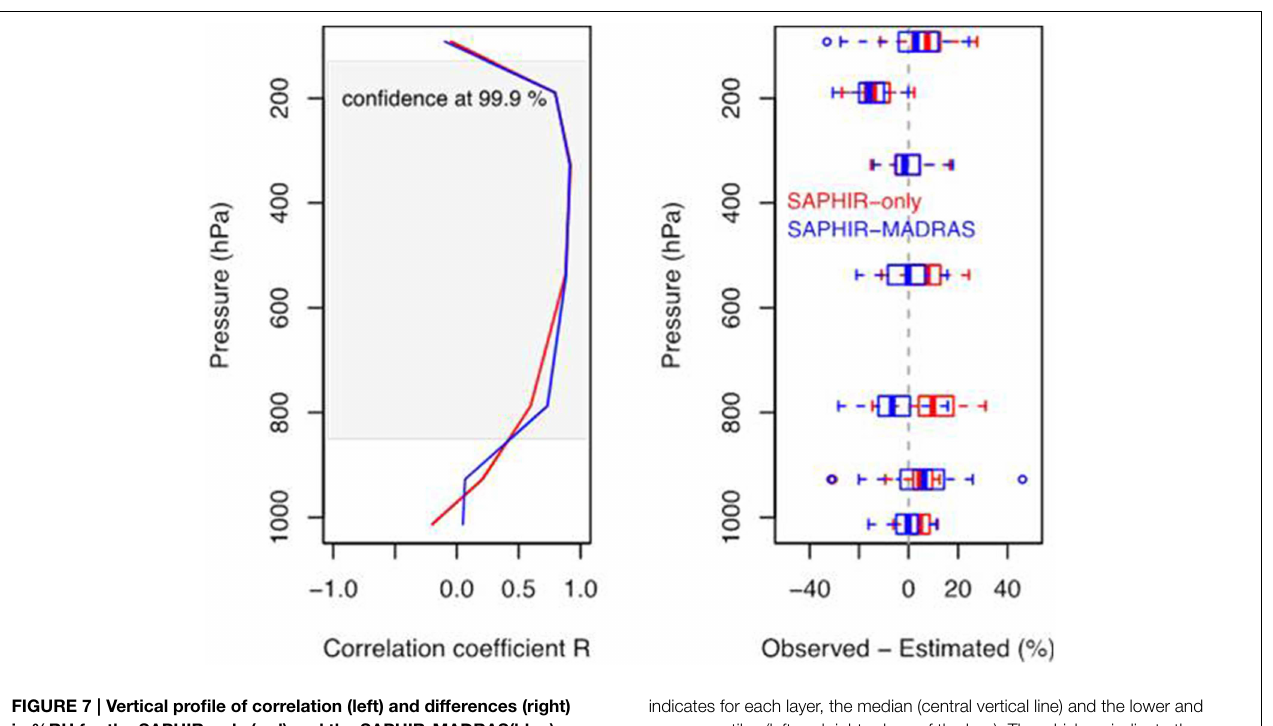
FIGURE 7 | Vertical profile of correlation (left) and differences (right) in %RH for the SAPHIR-only (red) and the SAPHIR-MADRAS(blue) retrievals, computed over a subset of 50 radiosoundings from the CINDY/DYNAMO/AMIE campaign. For the profiles of the differences between the observed and estimated RH, the box and whiskers diagram